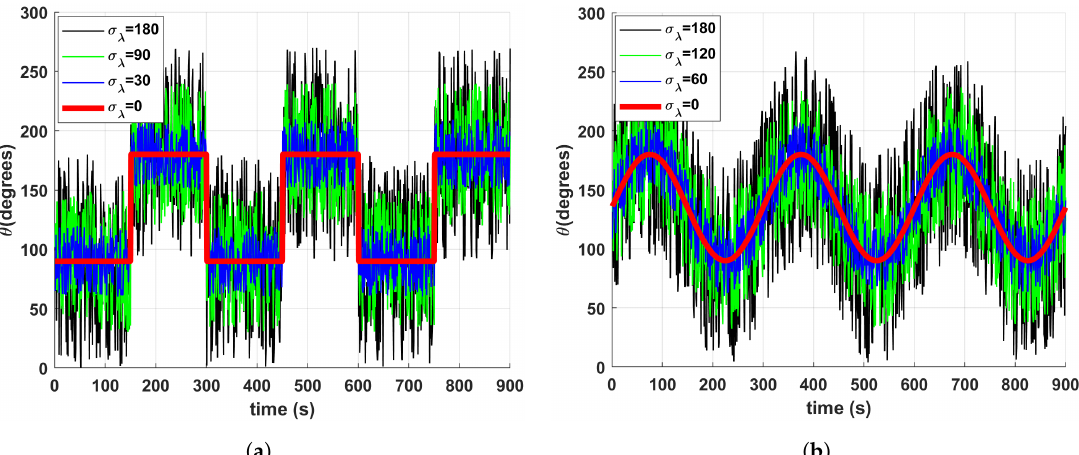
Figure 3. Examples of simulated wind direction signals under different noise levels. ( a ) Squared waveform. ( b ) Sinusoidal waveform.